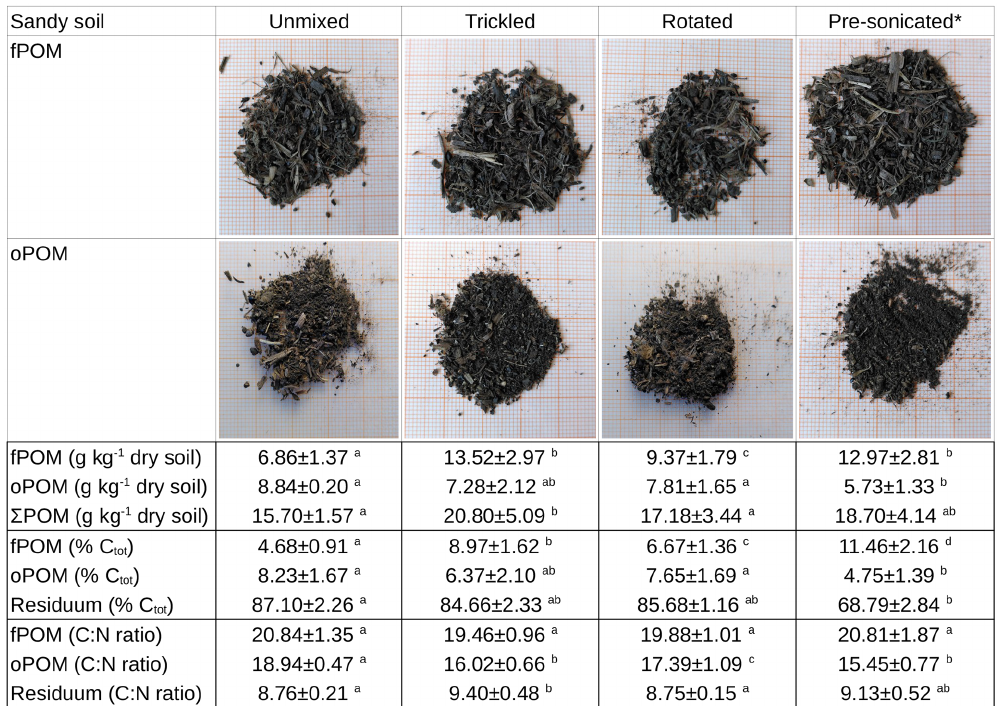
Table 2. Soil organic matter (SOM) release of a sandy topsoil after different approaches for merging sample and dense medium. fPOM refers to the free particulate organic matter floating after application of 0JmL − 1 , oPOM to the occluded particulate organic matter released after application of 50JmL − 1 ( ∗ in case of the treatment with minimum ultrasonication 3 and 47JmL − 1 , respectively). C tot refers to the percentage of total SOC contained in each fraction. ± refers to the standard deviation. Small superscripts are Tukey’s characters ( a, b, c, d ) and mark significant differences between the treatments of the loamy soil ( p < 0 .